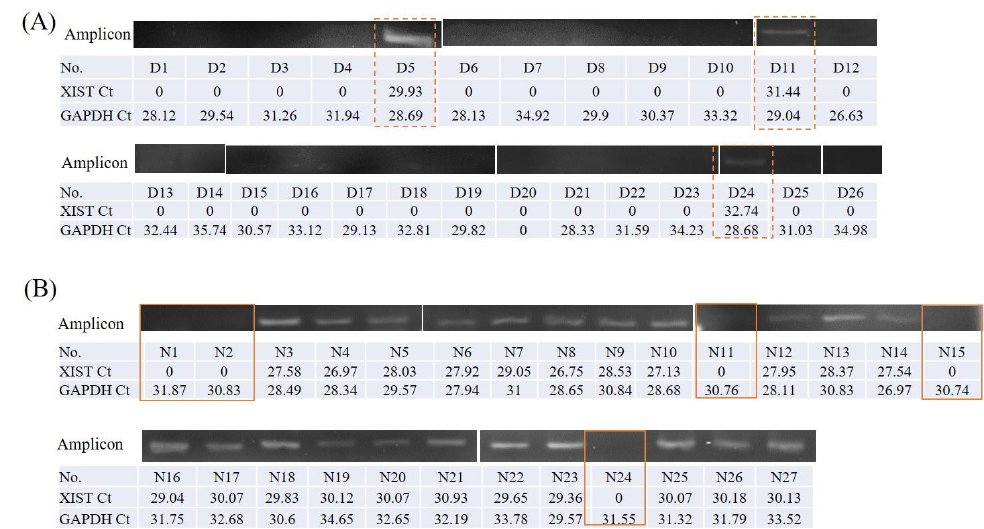
Figure 1. The salivary lncRNA XIST expression in female participants: ( A ) the amplicons and Ct value of XIST and GAPDH among females with OSCC ( n = 26). The dotted line circles the subjects who express salivary XIST. Only 3 females with OSCC showed positive expression. ( B ) The amplicons and Ct value of XIST and GAPDH among females without OSCC ( n = 27). The solid line circles the subject who lacks salivary XIST amplicons. Five control group females showing negative expression.